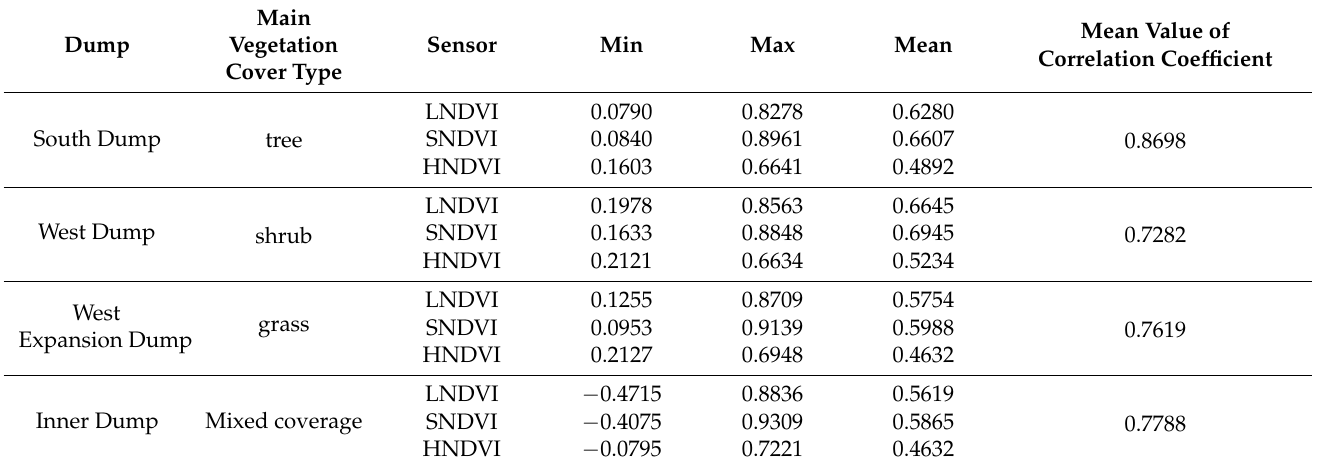
Table 7. NDVI statistical characteristic values based on different vegetation cover